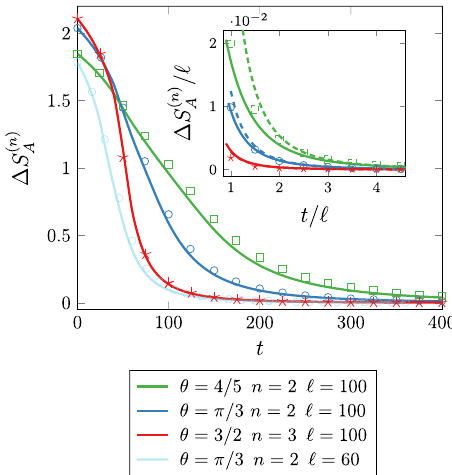
Fig. 3 | Time evolutionofthe Rényi entanglement asymmetry Δ S ð n Þ A ð t Þ after the quench (11). The symbols are the exact numerical results for various values of the subsystemlength ℓ ,thereplicaindex n ,andtheinitialtiltingangle θ (seeMethods). The continuous lines are our prediction obtained by plugging the charged moments reported in Methods into (4) and (2). In the inset, we check the asymp- totic behavior (13) (full lines) and (14) (dashed)of Δ S ð n Þ A ð t Þ for large t / ℓ . Source data are provided as a Source Data fi